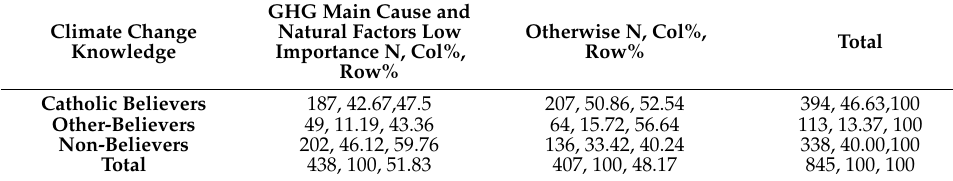
Table A6. Cross-table religious groups and CC knowledge.